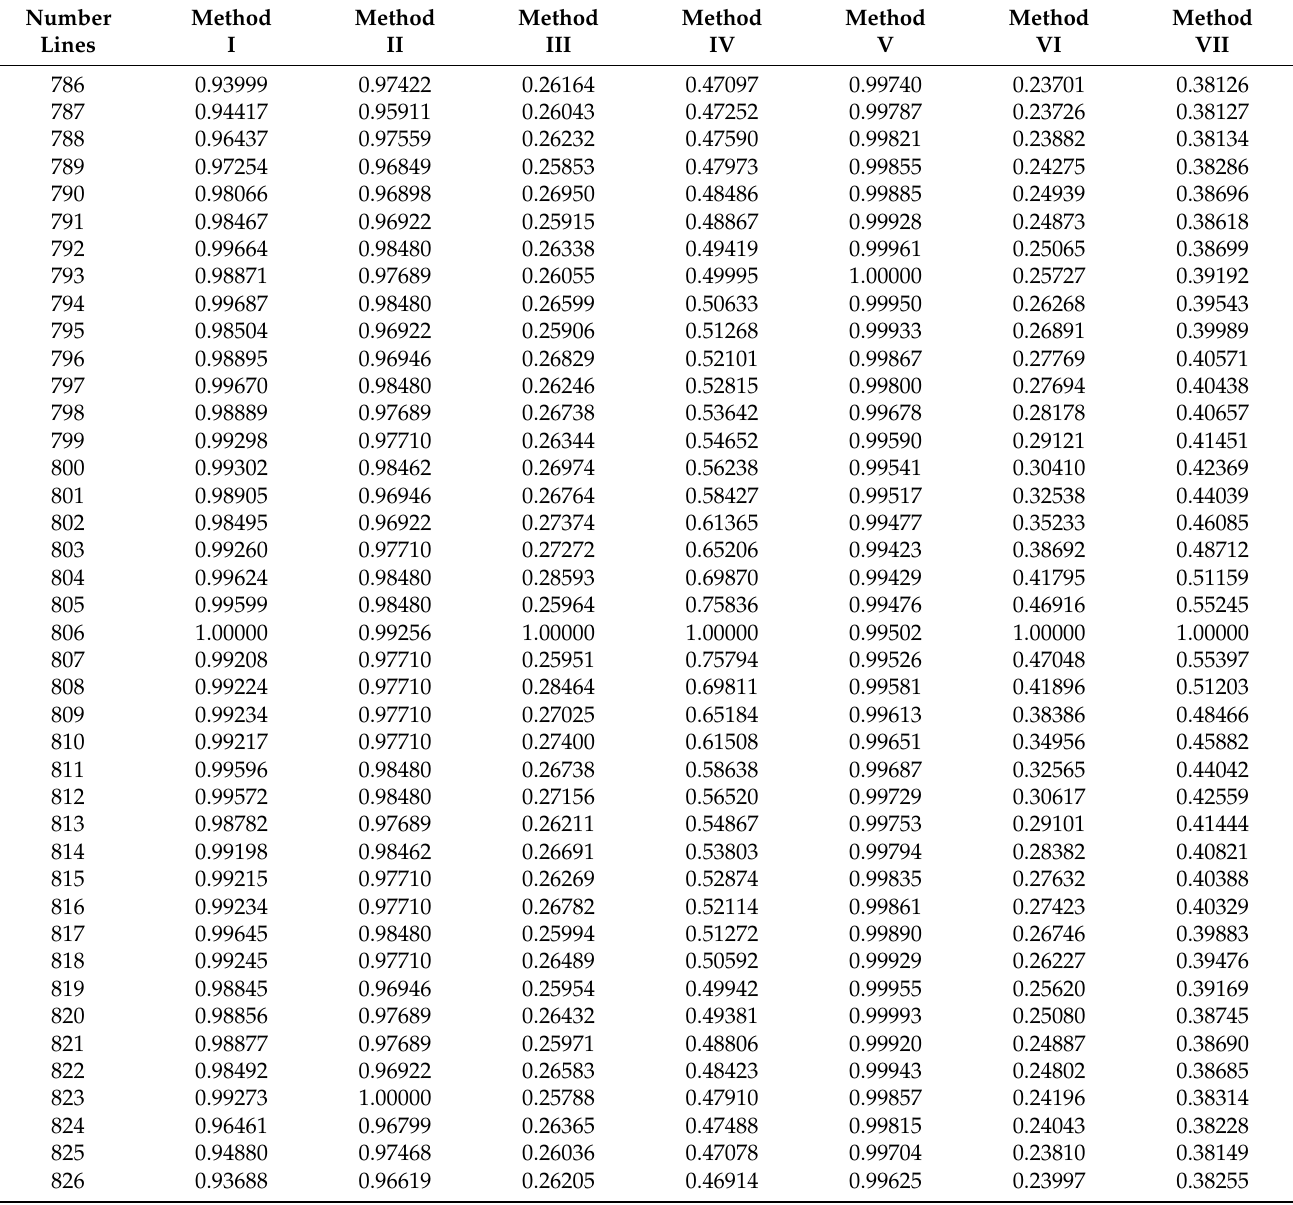
Table 3. Normalized values (in relation to the maximum value) of the variability of measures as a function of the number of image lines, supporting the determination of the correct number of lines of the image reproduced for the source image in the form of a picture from Figure